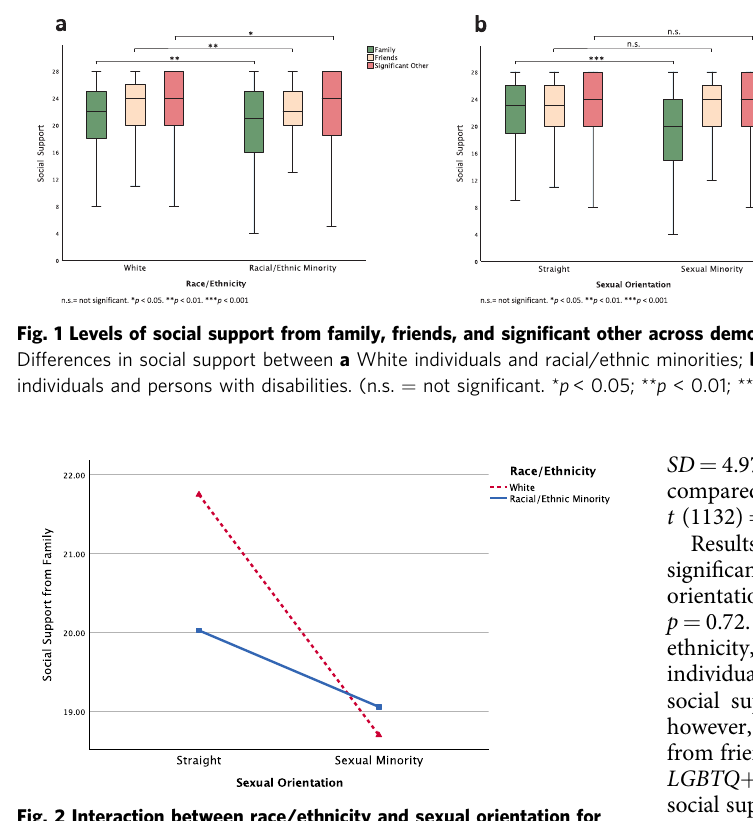
Fig. 2 Interaction between race/ethnicity and sexual orientation for social support from family. Note : All other nonsigni fi cant interactions between variables are not